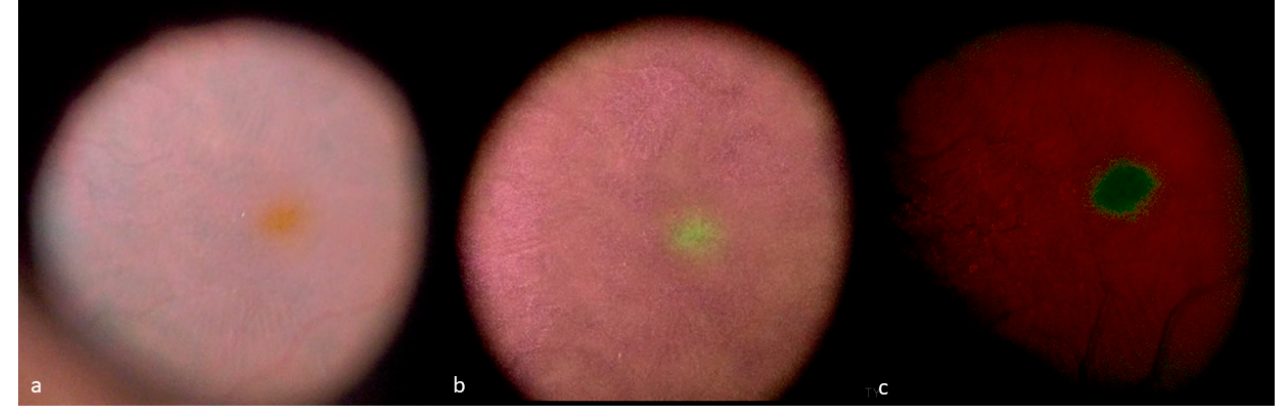
Figure 4. Enhancement of MP visualization in a case of epiretinal membrane surgery. ( a ) Standard colors, ( b ) filter 1, ( c ) high-enhancement of MP filter; additional changes were applied to filter 1: 32.02 for brightness, 69,70 for contrast, 1.40 for gamma, 60 for hue, 50% for color saturation, and 6000 kelvin for color temperature.